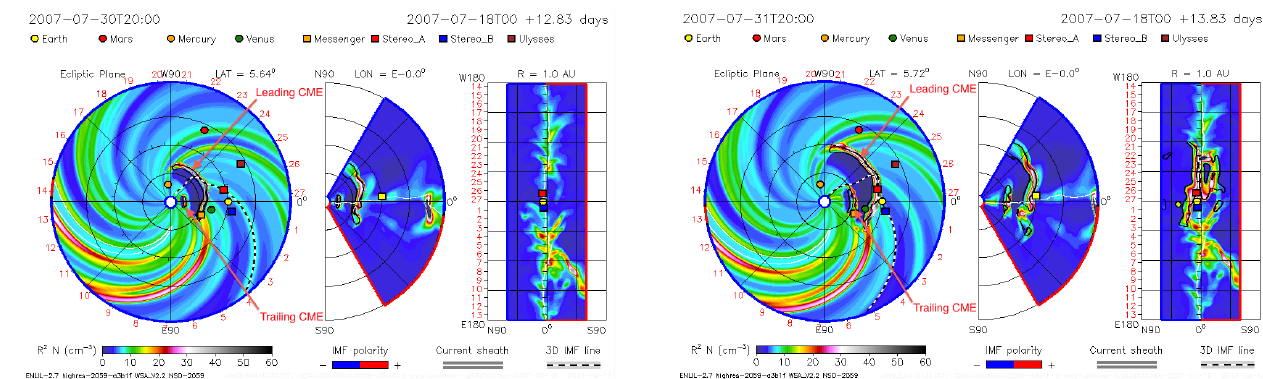
Fig. 2. The CCMC’s ENLIL with a cone model simulation results. The estimated arrival time of the leading partial halo CME at the Earth is approximately 20:00 on 31 July 2007 using the above sim- ulation results. The red arrows mark the leading and trailing